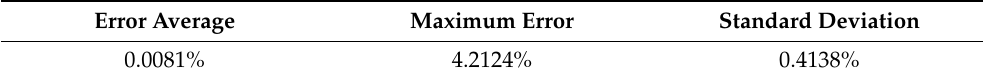
Table 9. Statistical measures: testing C.